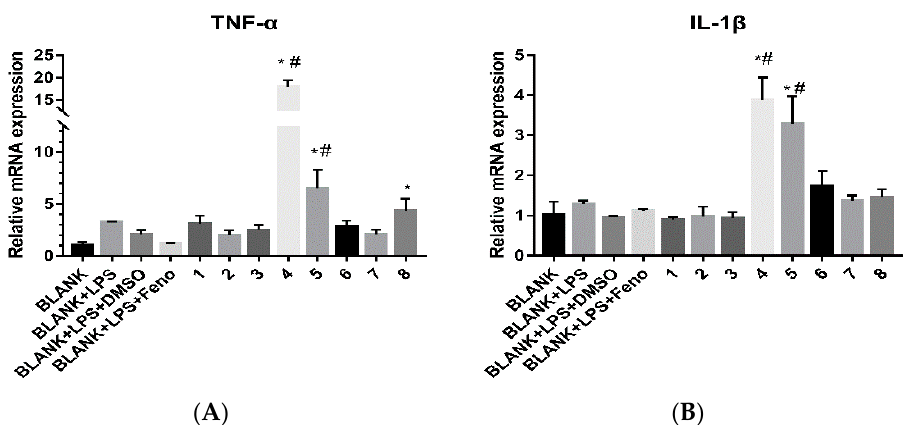
Figure 5. The influence of eight compounds on immuno-regulation factors over a period of 24 hours. ( A ) for the factor TNF- α and ( B ) for the factor IL-1 β . The “*” indicates that there were significant differences ( p < 0.05) between other compounds and the BLANK group amd the “#” indicates that there were significant differences ( p < 0.05) between other compounds and the BLANK + LPS group. Each value represented the means ± SD of three independent experiments.